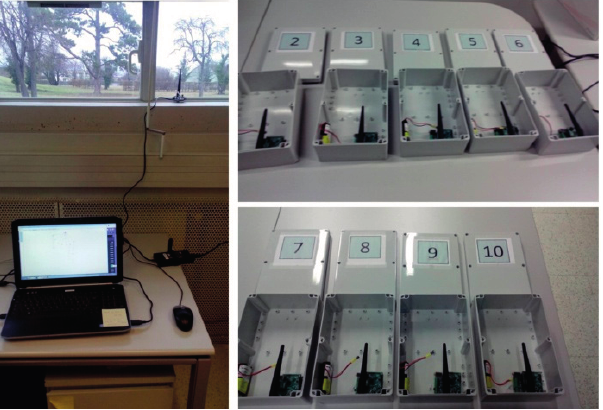
Figure 6. Testbed setup: sink node and nine IWoTCore Ext_MiLive nodes for outdoor environment